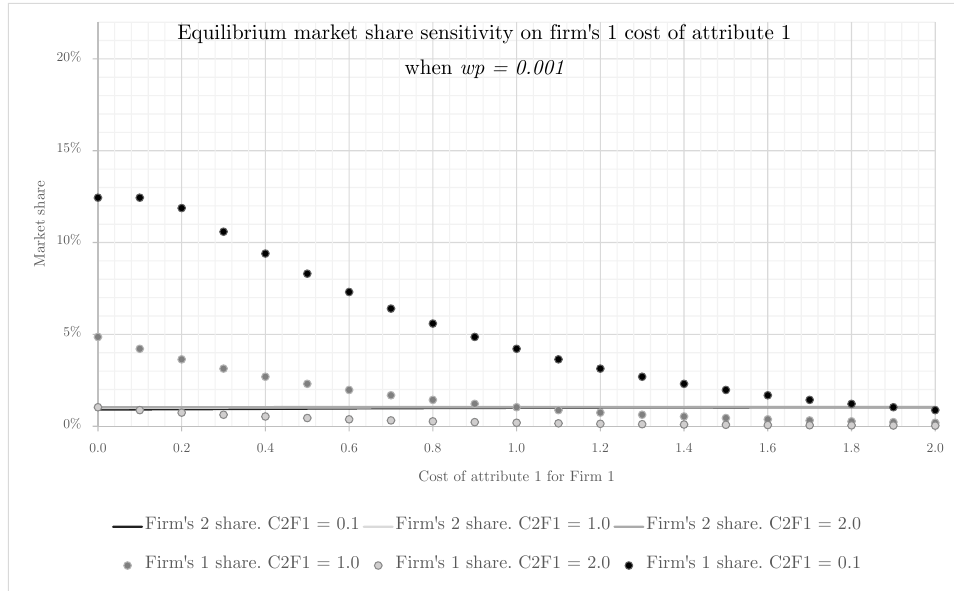
Figure A5. Firms’ market share varying attributes’ cost of Firm 1 when wp ≈